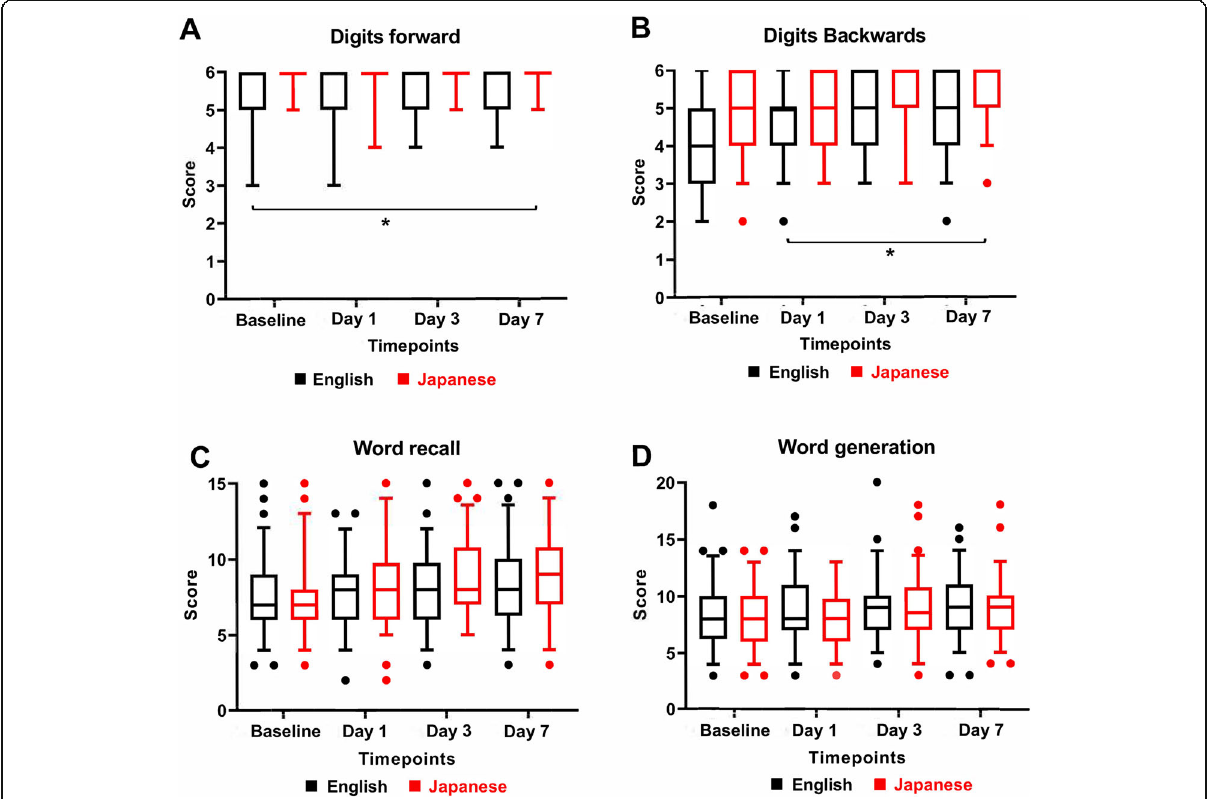
Fig. 1 Cognitive recovery of the Postoperative Quality of Recovery Scale within bilingual volunteers. a Digit forwards, b digits backward, c word recall, and d word generation within the Japanese-English bilingual volunteers across each timepoints of the study. The graphs are displayed as a box and whisker plot with the line being the median, the box showing the interquartile range and the whiskers showing the 5 and 95 percentiles of the data including outliers.* p <0.5 for pairwise comparisons using Kruskal-Wallis H test the non-parametric analysis of K